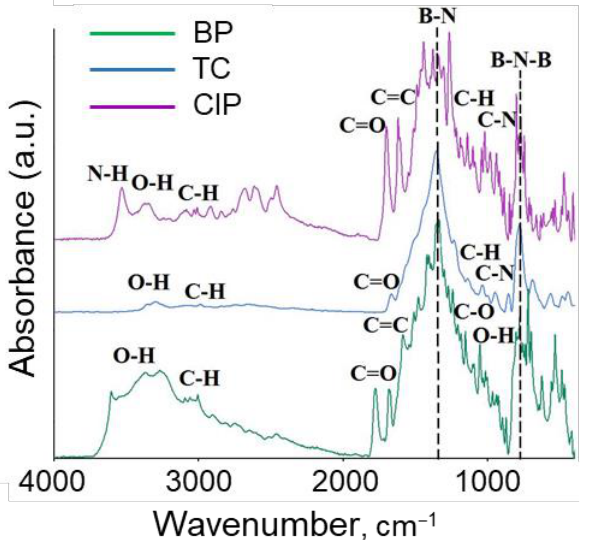
Figure 6. FTIR spectra of BNNPs after adsorption of benzylpenicillin (BP), tetracycline (TC), and ciprofloxacin (CIP).